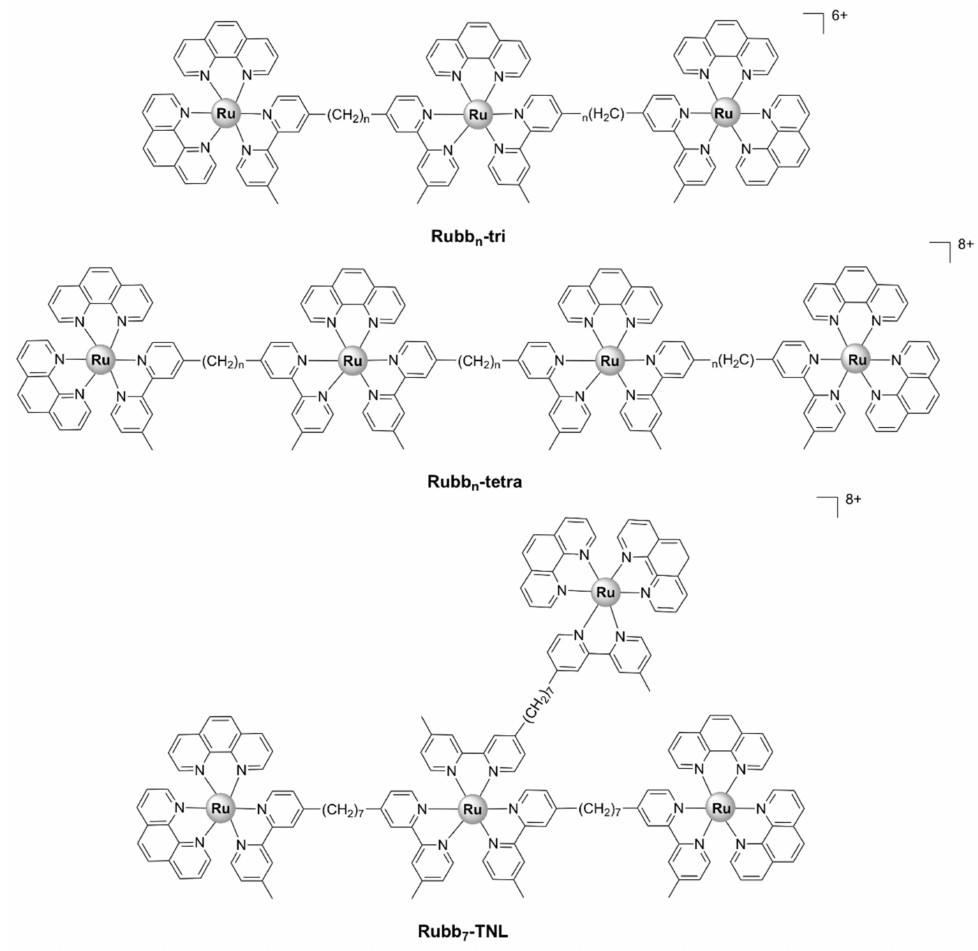
Figure 15. Chemical structures of inert tri- and tetra- nuclear ruthenium complexes, where n = 7, 10, 12 or